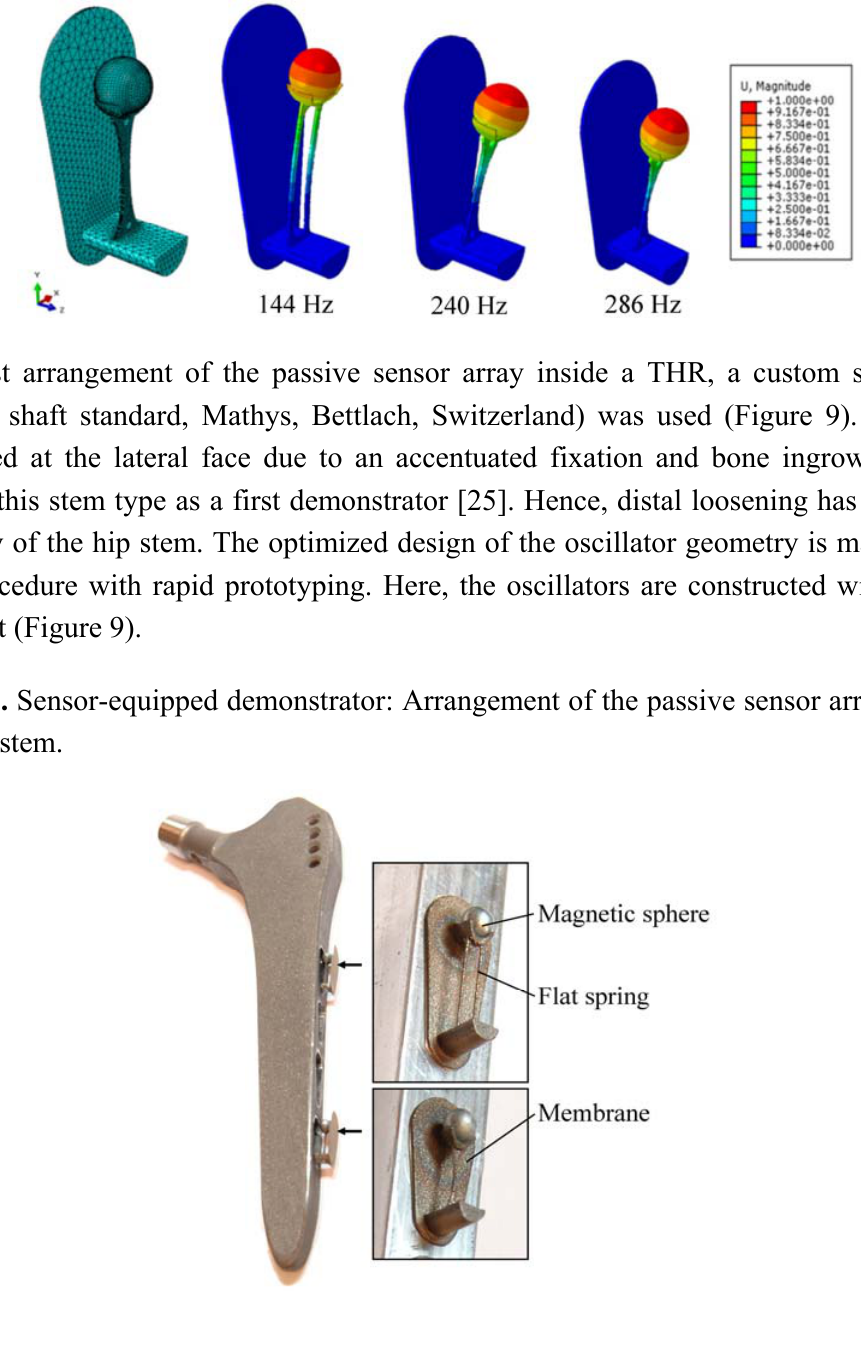
Figure 8. Results of the simulated oscillators creating the geometry variations.